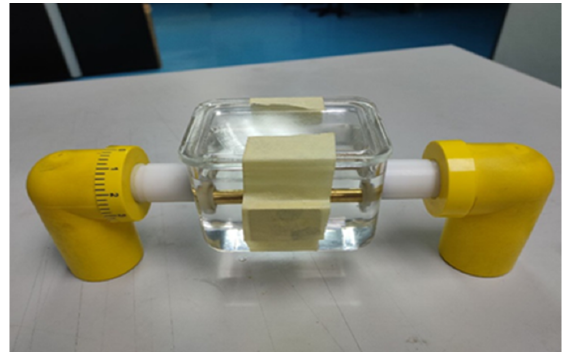
Figure 2. Test vessel with magnet.